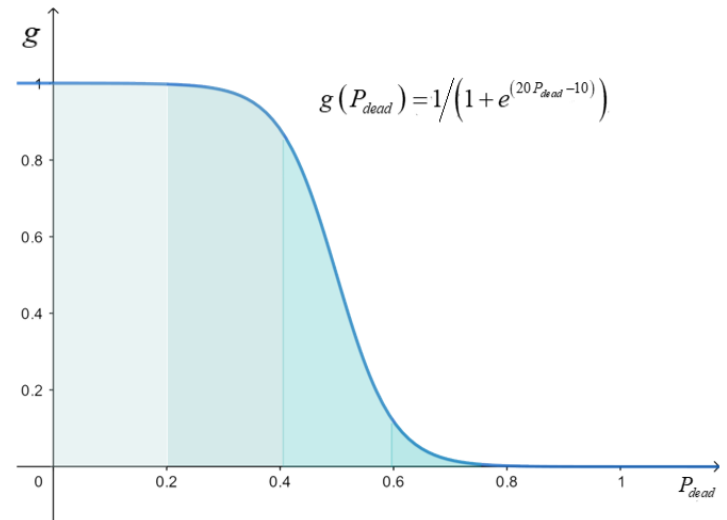
Figure 8. Curve of adaptive adjustment function.